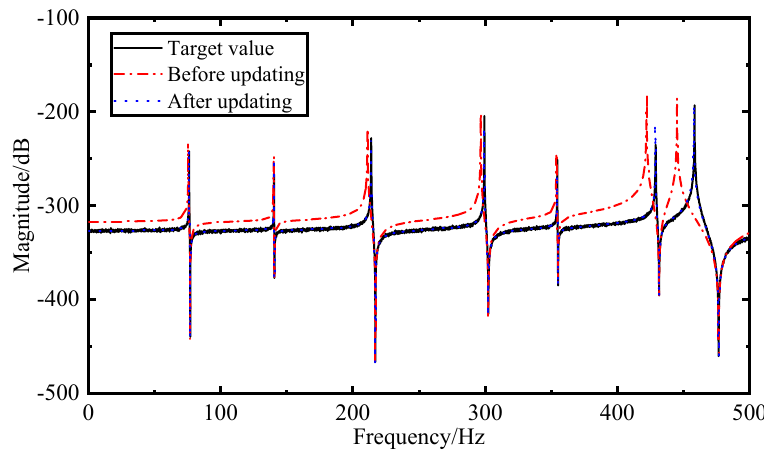
Figure 7. Comparison of FRFs data measured at Node 10 under 5% random white noise. Table 3. Comparison of Frequency Values between FE Model and Target Model Under 5% White Noise.